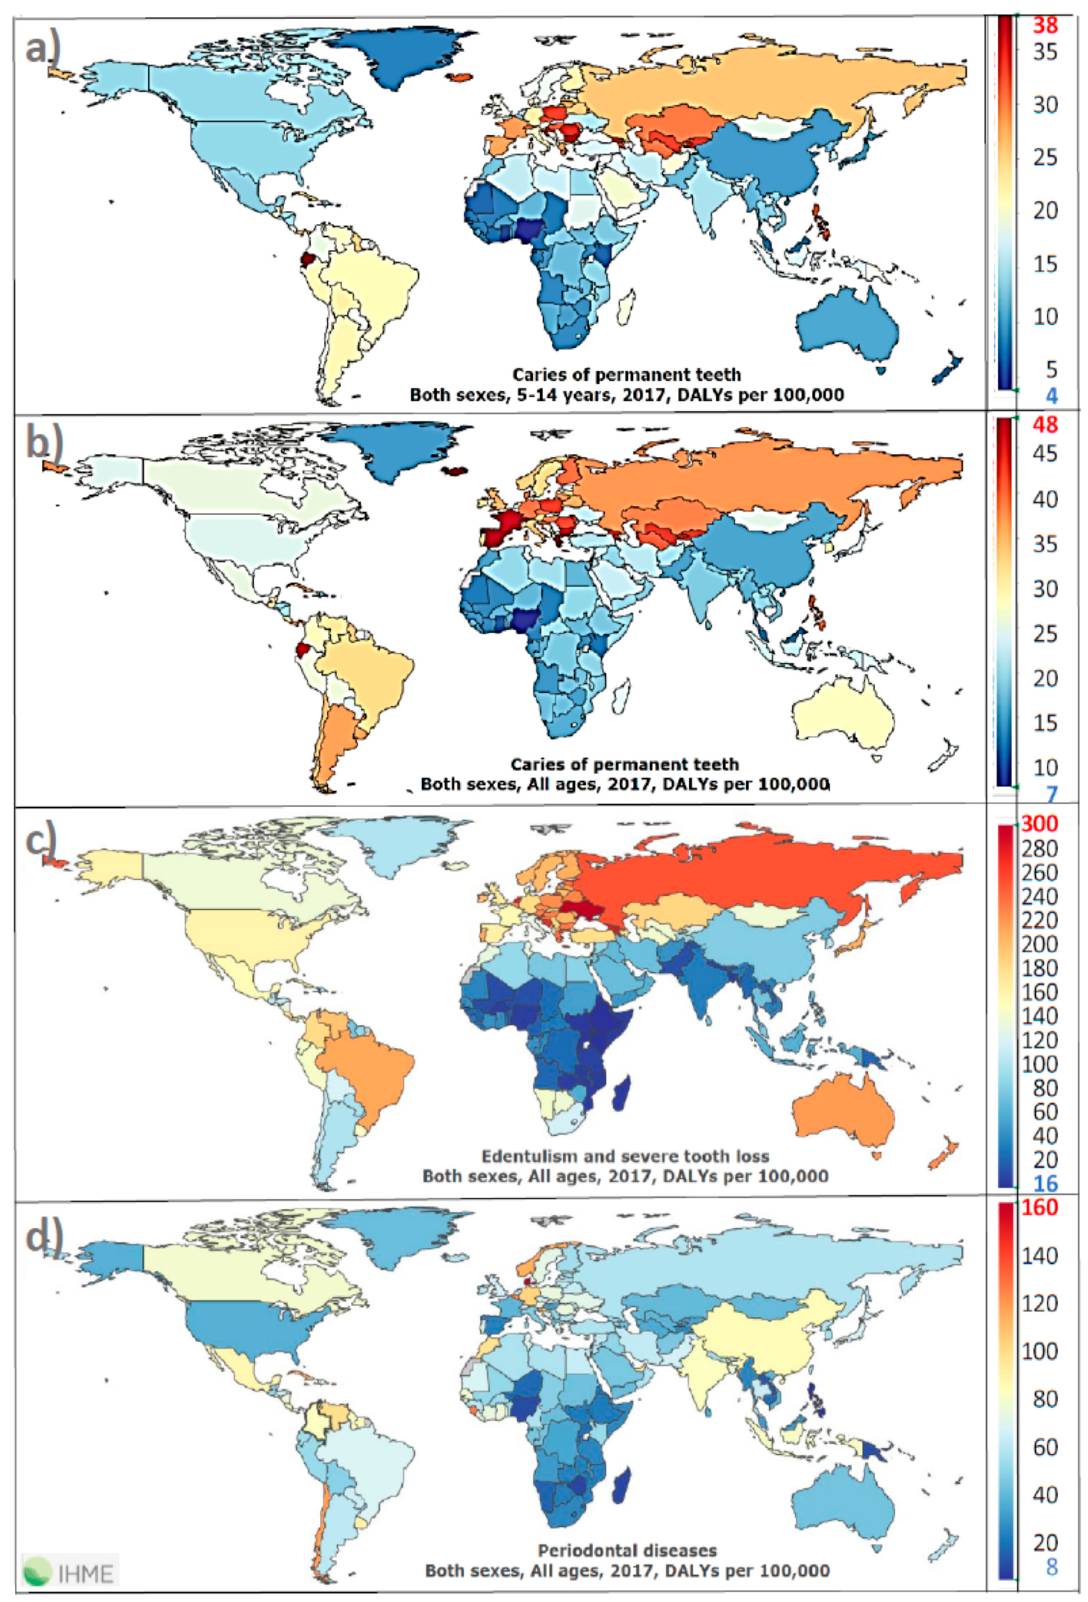
Figure 4. The spread of caries in 2017 in various countries of the world (no newer analyses); ( a ) in the 5–14 age group and ( b ) regardless of age; ( c ) The spread of edentualism and severe tooth loss; ( d ) The spread of periodontal diseases regardless of age.